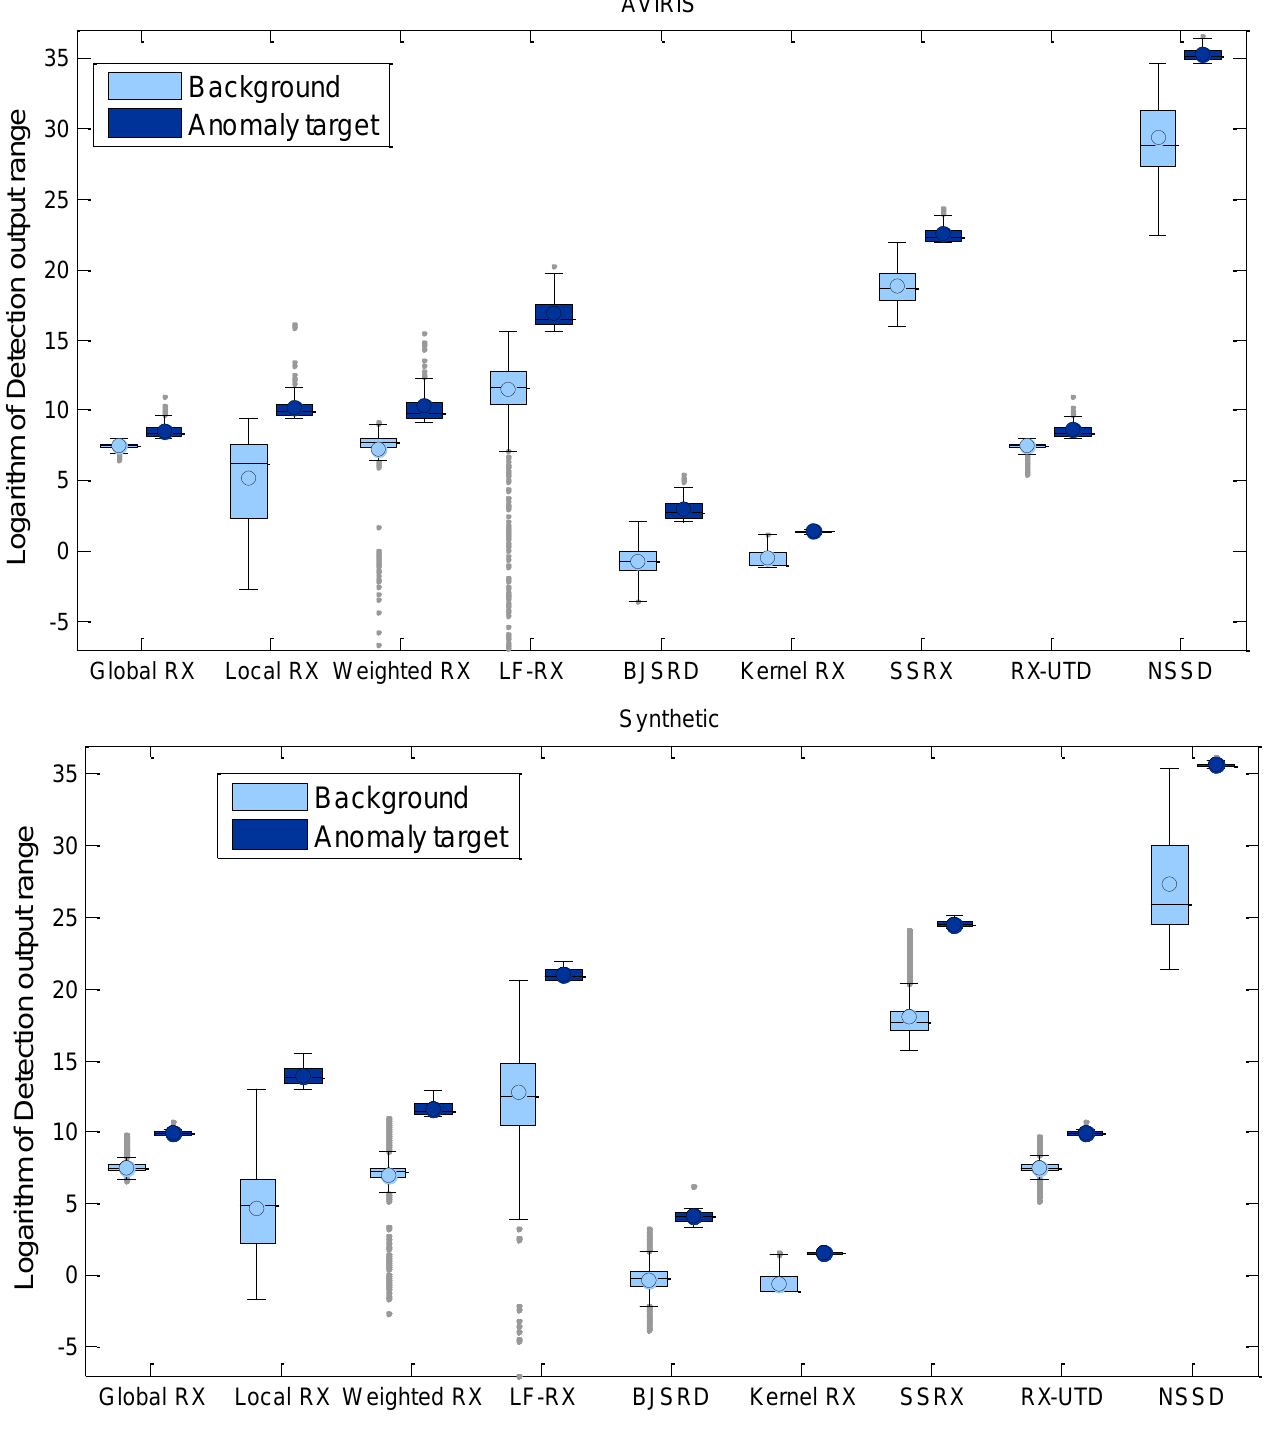
Figure 6. Separability diagrams for AVIRIS and synthetic datasets (Individual boxes show the output range of each detector for anomaly targets and